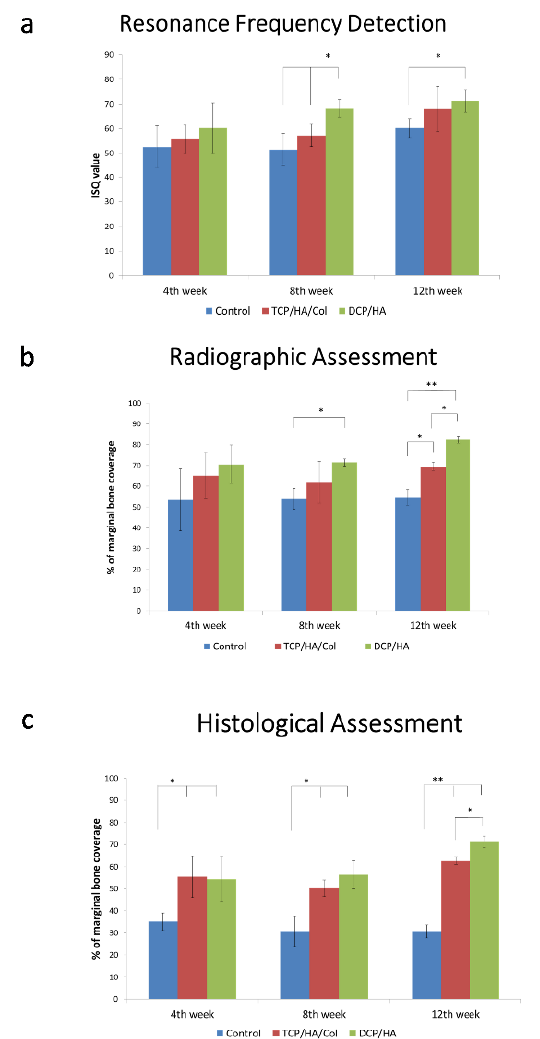
Figure 3. Resonance frequency analysis. Radiographic and histopathological assessment for implant stability after inserting various grafts for healing the peri-implant bony defect. ( a ) After 4, 8, and 12 weeks, the DCP / HA-treated defect exhibited the highest implant stability quotient, followed by the TCP / HA / Col-treated group and the control group. At 8 and 12 weeks following implantation, resonance frequency analysis of the DCP / HA group revealed significantly higher implant stability compared with the control group ( p < 0.05). ( b ) Radiographic assessment of defect healing. After healing for 4 weeks, the DCP / HA- and TCP / HA / Col-treated defect groups exhibited a higher percentage of marginal bone coverage with a degree of radiopacity at the implant surface than the control group did. At 8 and 12 weeks of healing, all of the groups exhibited various degrees of bone healing. However, the highest percentage of marginal bone coverage based on radiographic evaluation was the DCP / HA-treated defect group, followed by the TCP / HA / Col-treated defect group and the control group. ( c ) Histopathological assessment of the various grafts used in defect healing. At 4 weeks after the graft was inserted, the sections exhibited significantly higher amounts of new bone formation in the DCP / HA- and TCP / HA / Col-treated defect groups ( p < 0.01). After 8 weeks of healing, an increased amount of new bone formation was visible in the DCP / HA groups, whereas significantly less bone formation was observed in the control group. At 4, 8, and 12 weeks, the DCP / HA-treated sockets exhibited the highest percentage of marginal bone coverage, followed by the TCP / HA / Col-treated sockets and the control group. * and ** indicate statistically significant di ff erences ( p < 0.05 and p < 0.01, respectively) among the labeled